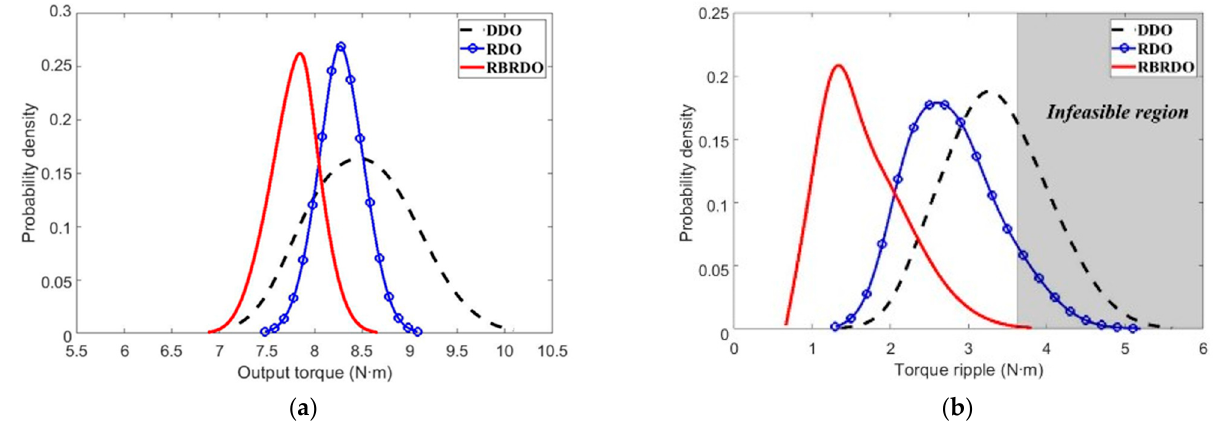
Figure 13. Comparison of DDO, RDO, and RBRDO results for ( a ) output torque and ( b ) torque ripple.